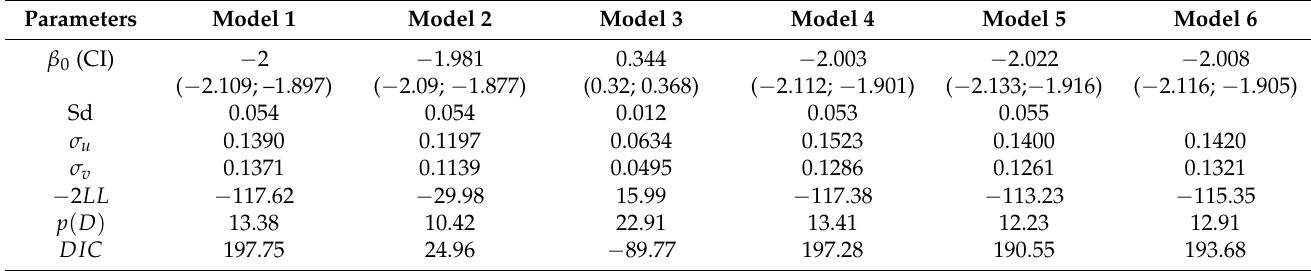
Table 3. A comparison of spatial models for mapping child underweight in Malawi using 2015-16